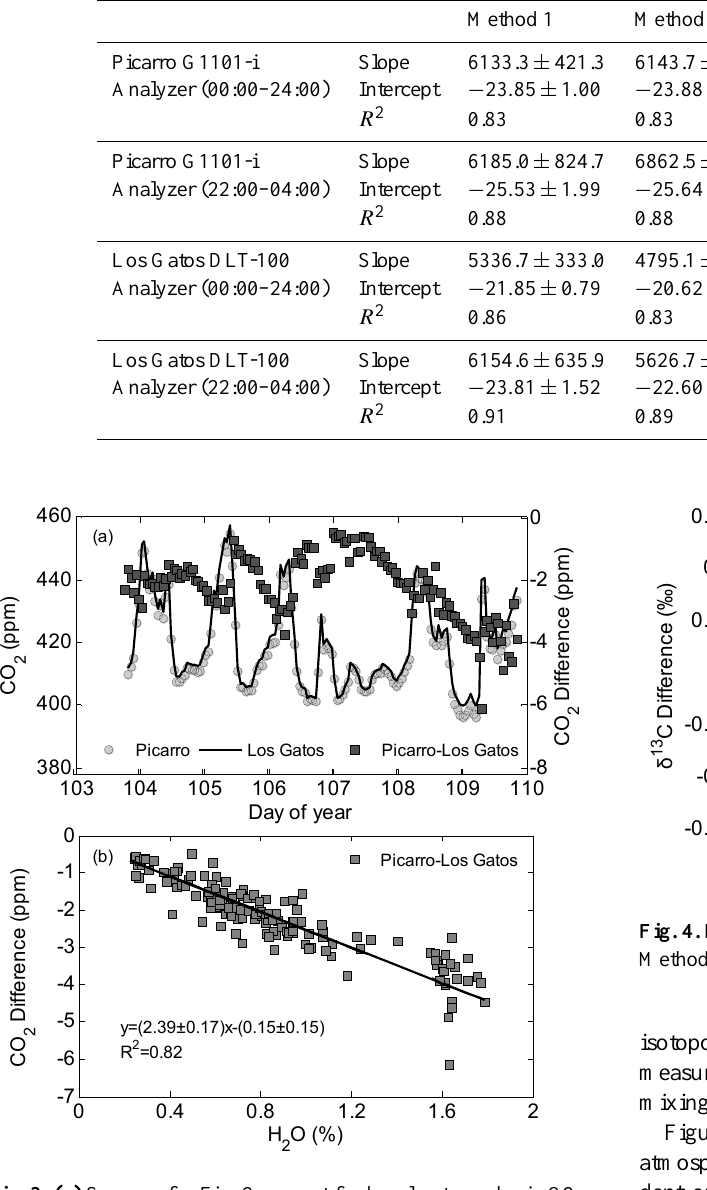
Fig. 3. (a) Same as for Fig. 2a except for hourly atmospheric CO 2 concentration and (b) dependence of their difference on the H 2 O concentration.